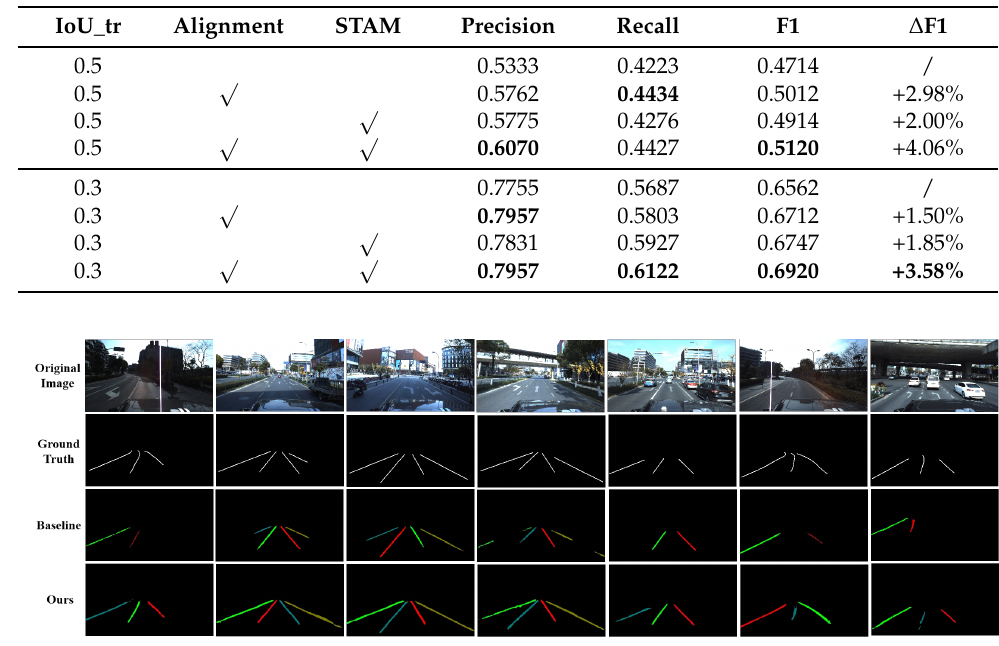
Figure 8. The visualization of lane mark detection results on the ApolloScape dataset. The color of lane marks is random, only for distinguishing different lane mark